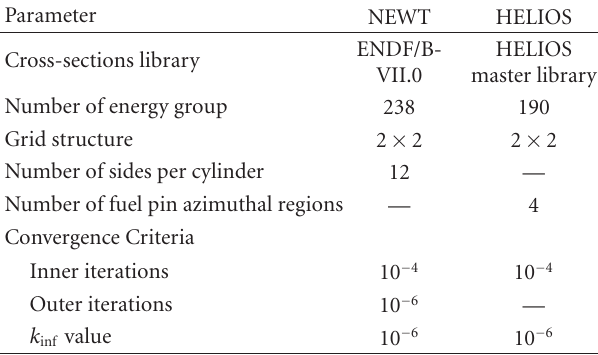
Table 1: Reference simulation